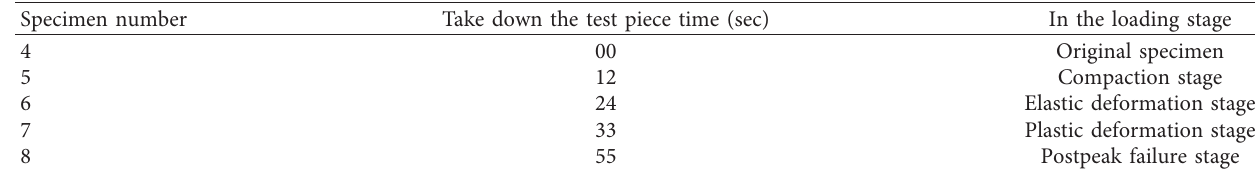
Table 2: Treatment table of backfill specimen.